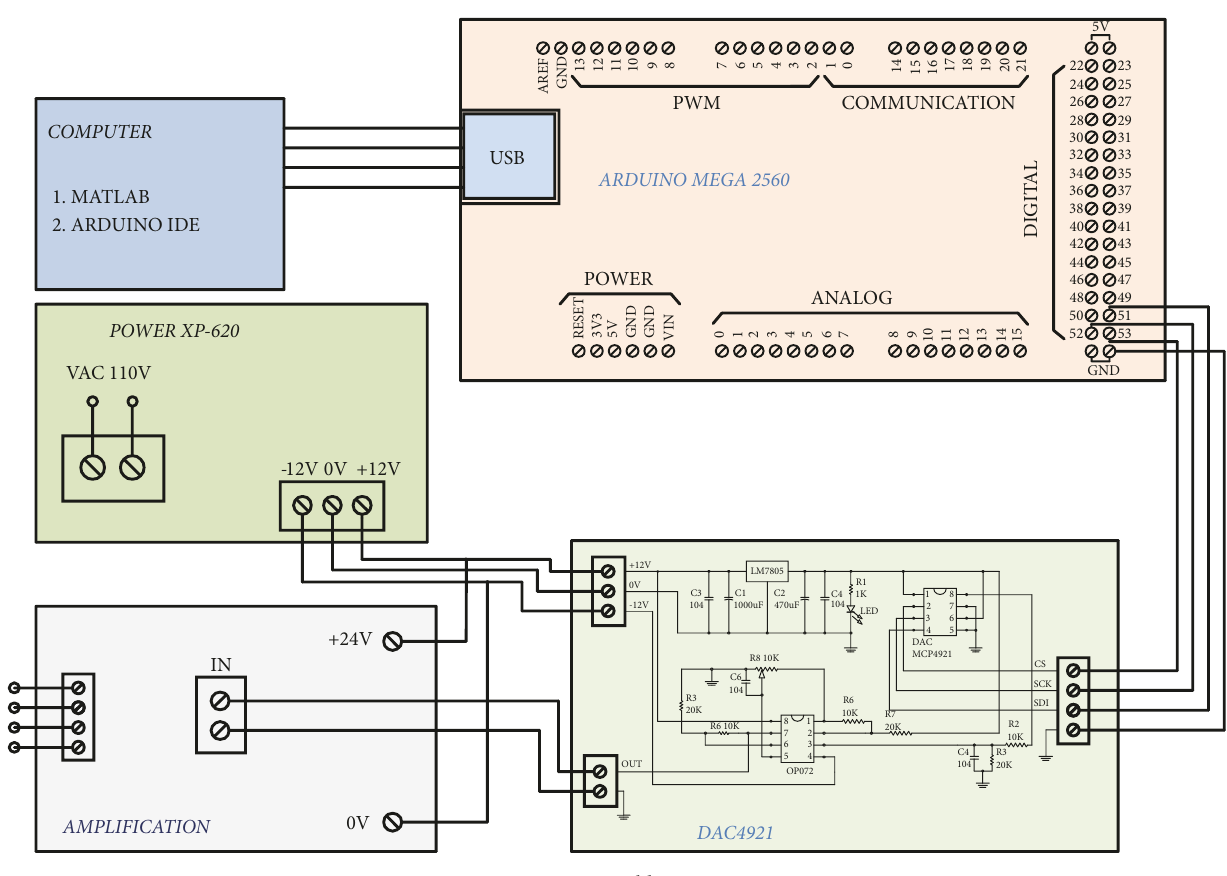
Figure 11: Assembly circuit.